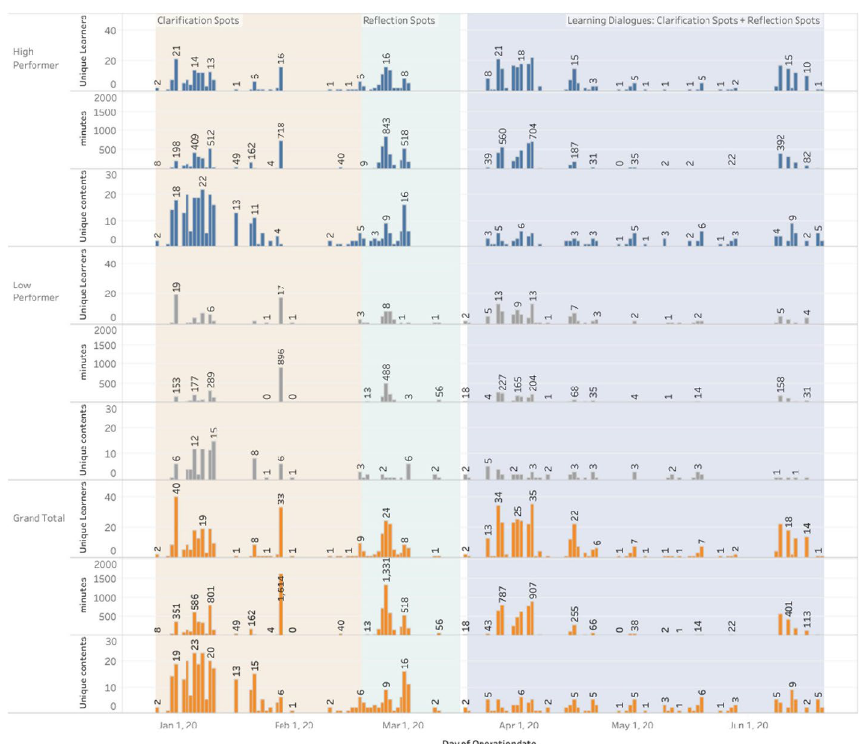
Fig. 5 Student engagement across different teaching phases (L, P, L